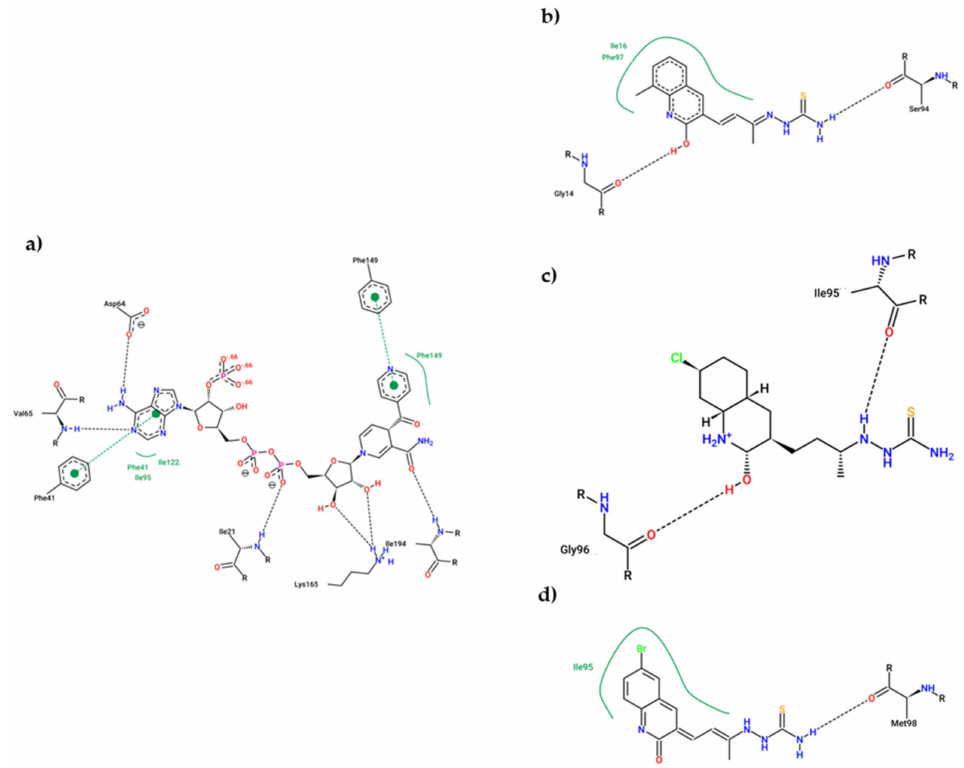
Figure 10. 2D Representation of the interaction between enoyl-acyl reductase and (4S)-isonicotinic- acetyl-nicotinamide-adenine dinucleotide ( a ), 11c ( b ), 11d ( c ), and 11e ( d